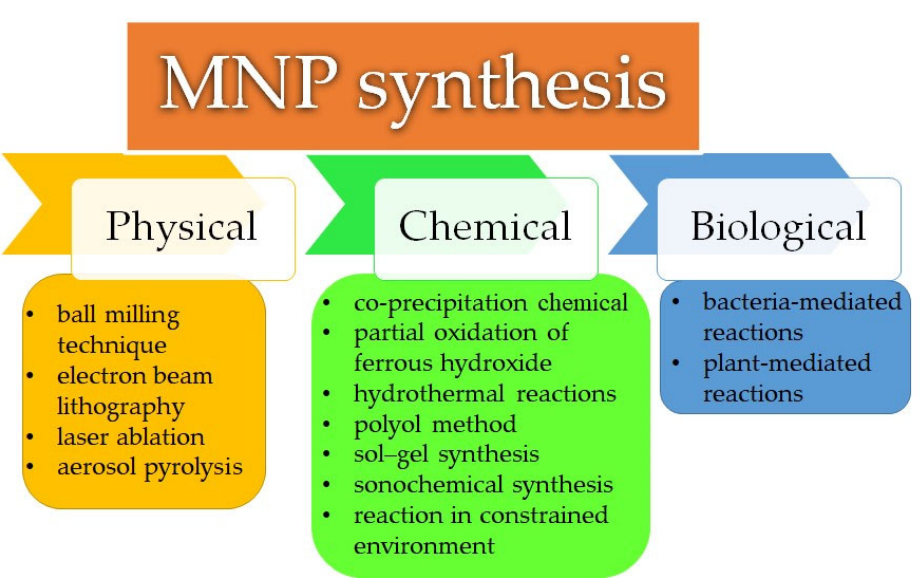
Figure 1. The main routes of MNP synthesis.